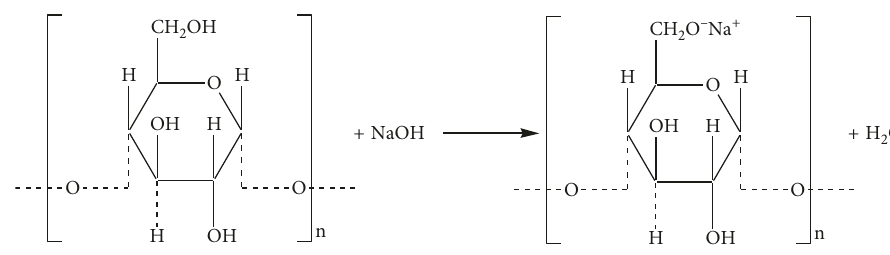
Scheme 7: Reaction between starch and sodium hydroxide.